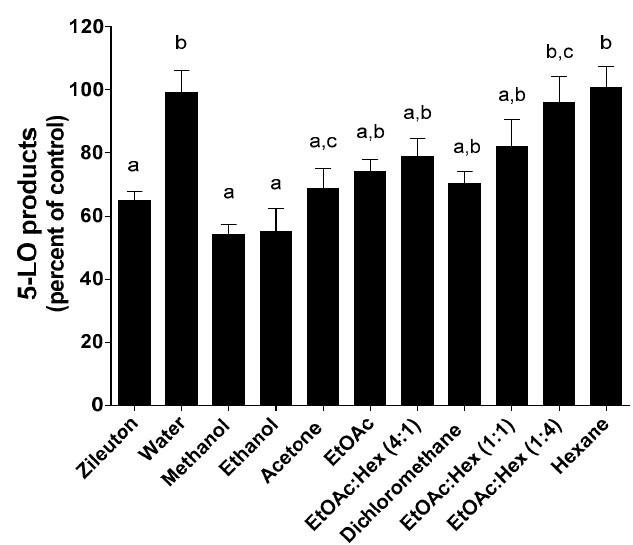
Figure 7. Inhibition of 5-LO product biosynthesis in HEK293 cells by Zileuton (1 µM) and all dry extracts (5 µg/mL) obtained following a SE. Values are the means ± SEM of at least three independent experiments, each performed in duplicate; values with different superscripts are significantly different ( p < 0.05) as determined by one-way ANOVA test with subsequent Tukey’s adjustment.